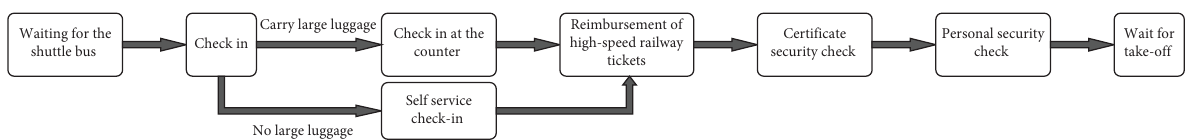
Figure 5: Logic diagram of passenger transfer